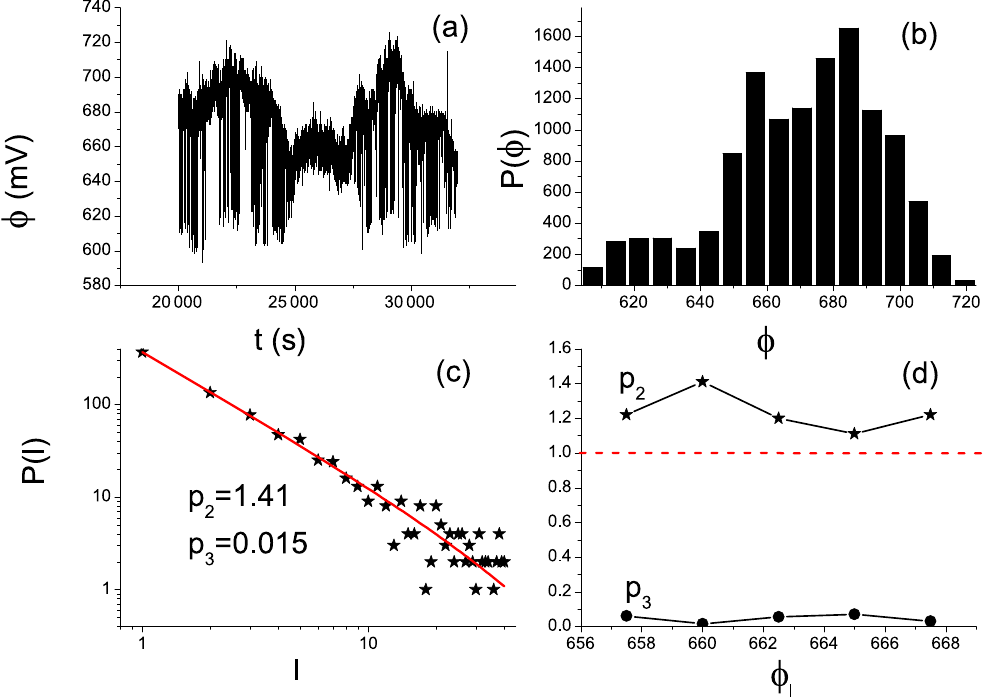
Figure 4. (a) The 12000-sample long critical window of the MHz EME that was recorded before the Cephalonia M w = 5 . 9 EQ at the Cephalonia station, while (b) , (c) , and (d) are similar to the corresponding parts of Fig. 2. In (c) , the distribution of laminar lengths is given for the end point φ l =